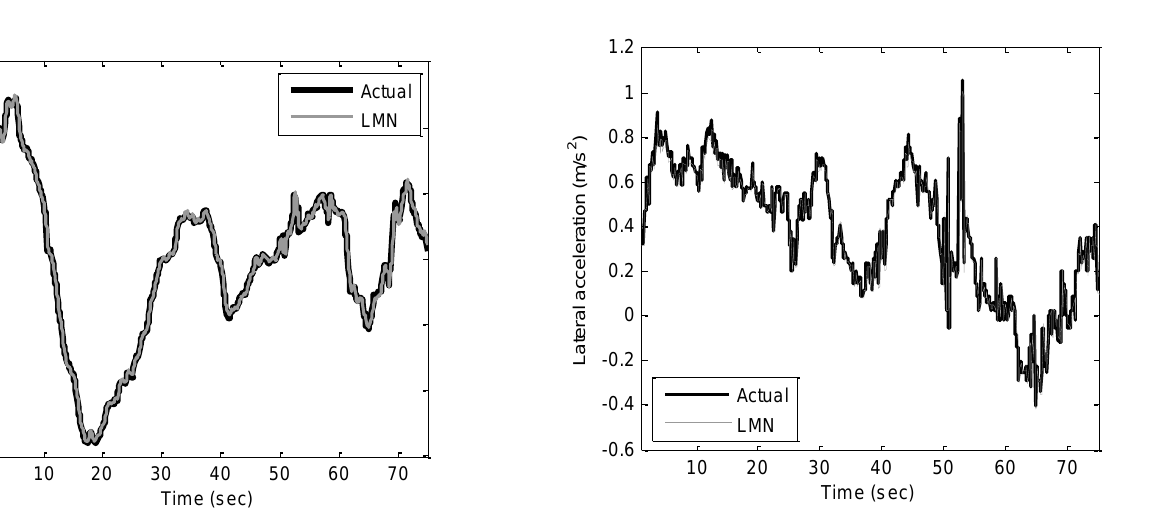
Figure 8. Lateral acceleration